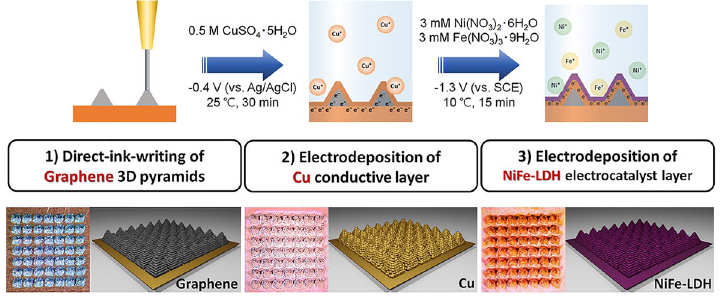
Figure 1. Schematic illustration of the fabrication of 3D-printed pyramid electrodes for OER in three successive steps. (1) Direct-ink-writing of graphene 3D pyramid array, electrodeposition of (2) Cu conductive layer and (3) NiFe-LDH electrocatalyst